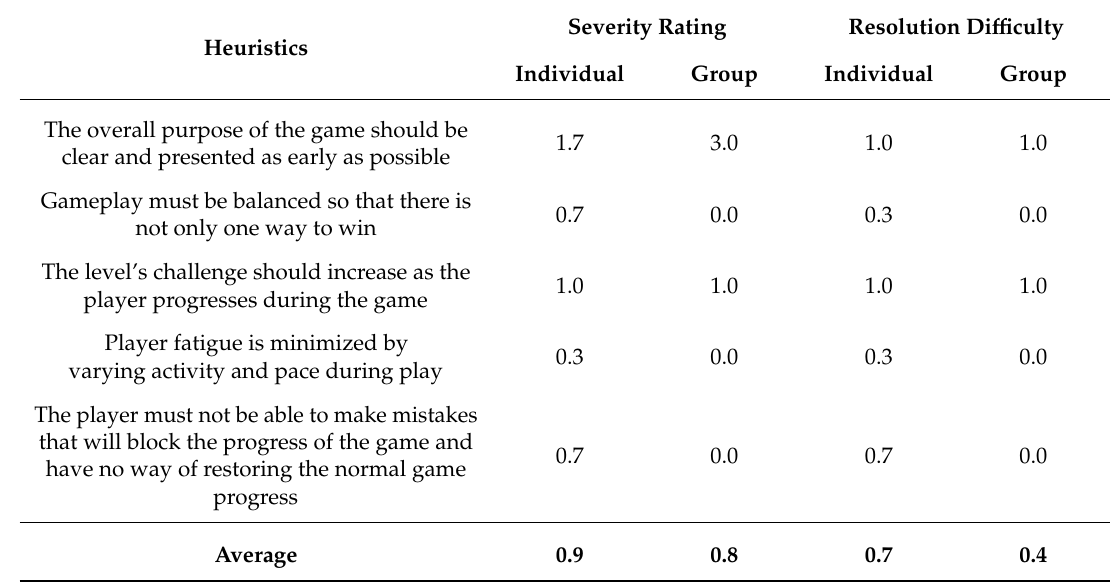
Table 6. Heuristics analysis of the game’s goals